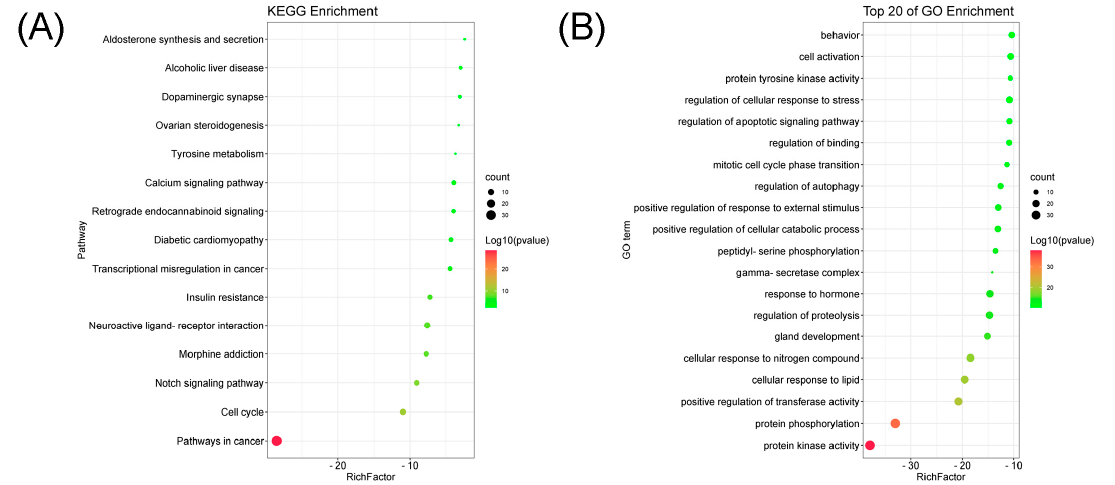
Figure 6. Bubble chart. ( A ) KEGG pathway enrichment analysis; ( B ) GO annotation